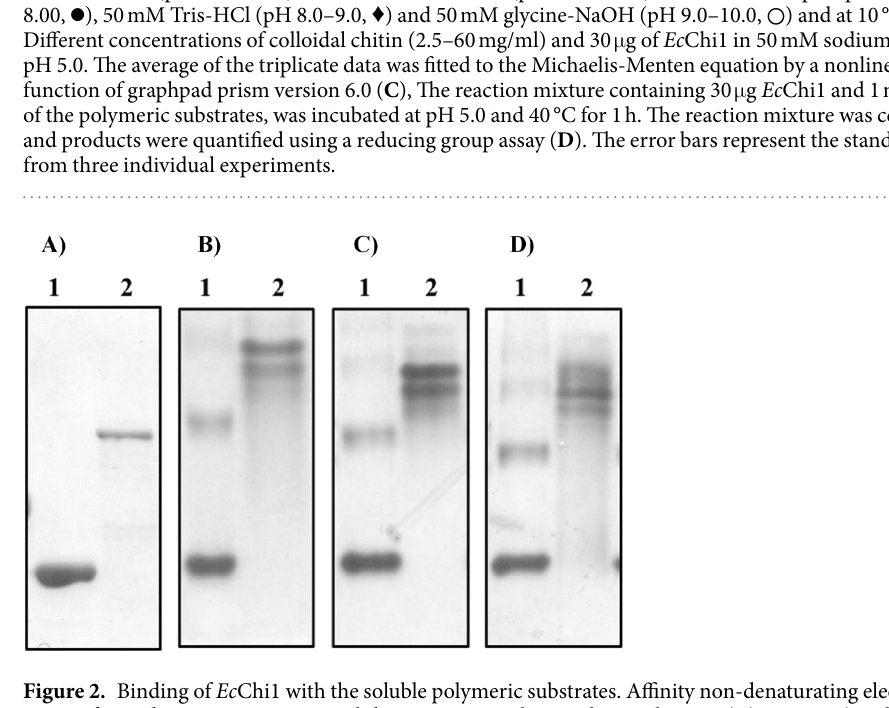
Figure 2. Binding of Ec Chi1 with the soluble polymeric substrates. Affinity non-denaturating electrophoresis was performed in 8% native PAGE gels by preparing with or without substrate. ( A ) Proteins ( Ec Chi1 or non- interacting BSA) without substrate, while ( B ) with 0.1% (wt/vol) substrate glycol chitin, ( C ) CM-cellulose and ( D ) laminarin incorporated in gels. Proteins were visualized by Coomassie blue G-250 staining after electrophoresis. Lane 1. BSA, Lane 2. Ec